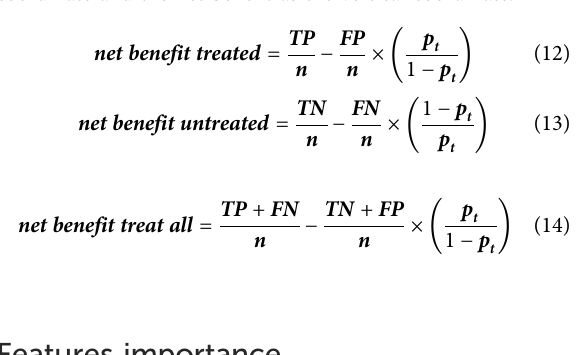
curve was drawn using the probability threshold as the horizontal coordinate and the net bene fi t as the vertical coordinate.